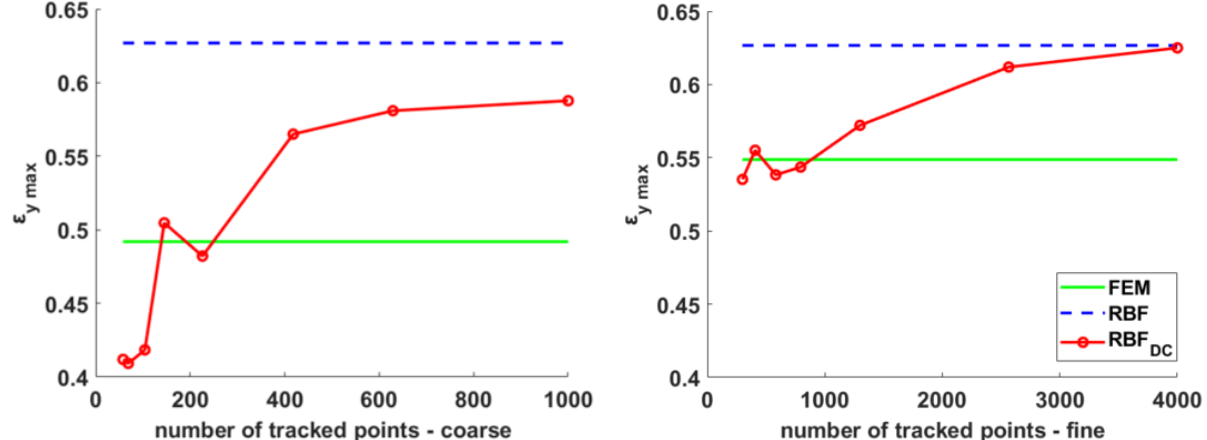
Figure 9. Maximum strain for the coarse ( left ) and fine ( right ) meshes computed using the proposed method while increasing the number of tracked points (red) and reference values on the same grid obtained with FEM (green) and RBF (dashed) computation.